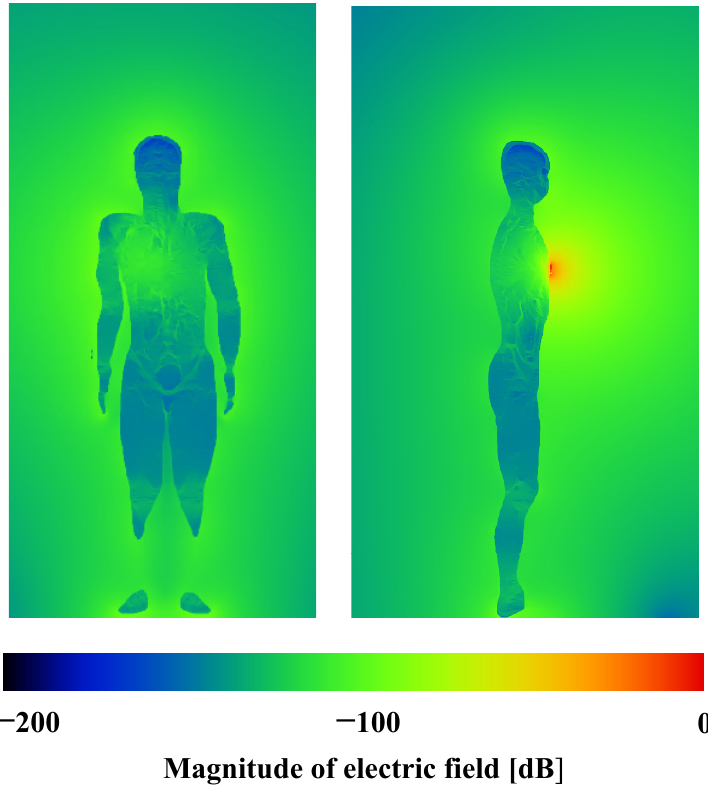
Figure 10. Electric field distribution at 10 MHz on a high-resolution human